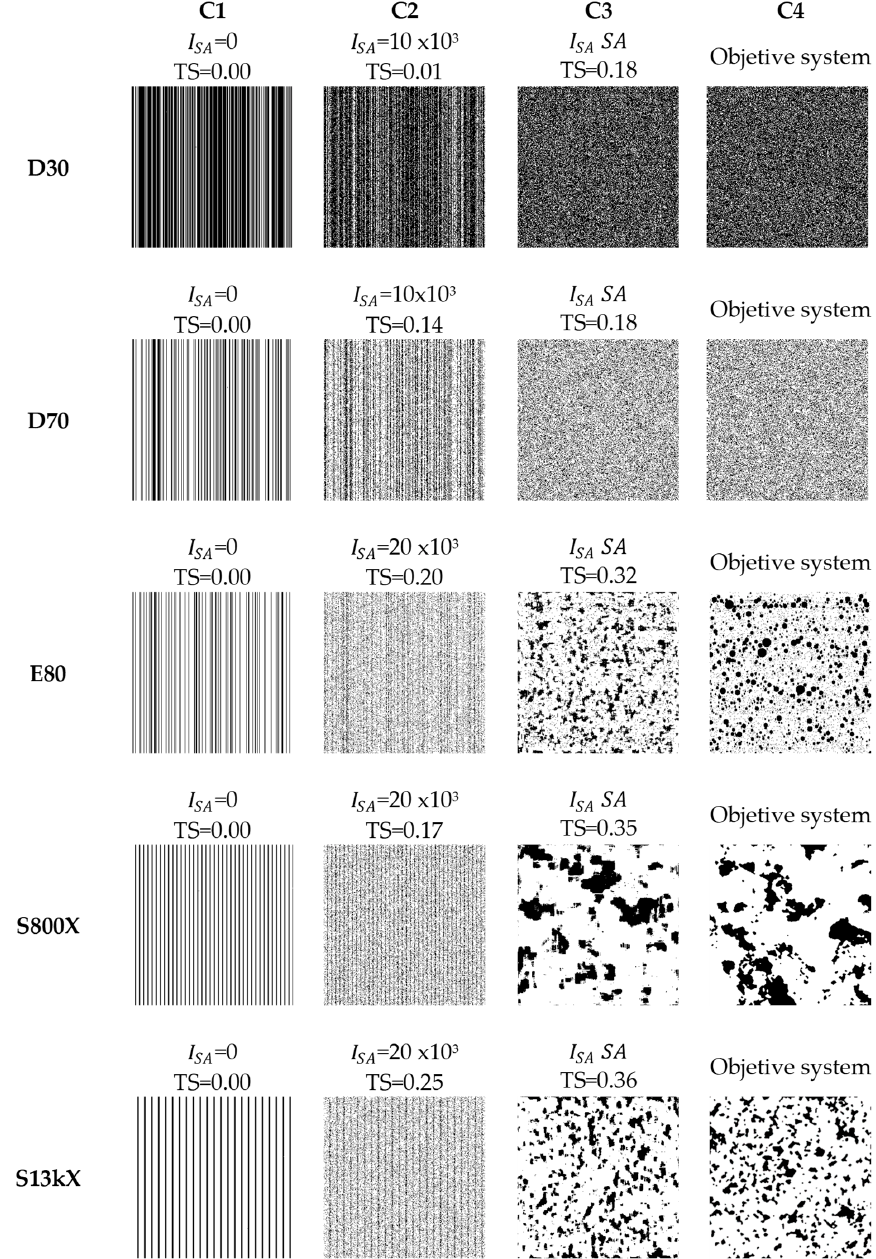
Figure 4. Representative images of the stirring process using simulated annealing (SA), TS values, and I SA moments are presented for samples D30, D70, E80, S13kX, and S800X.